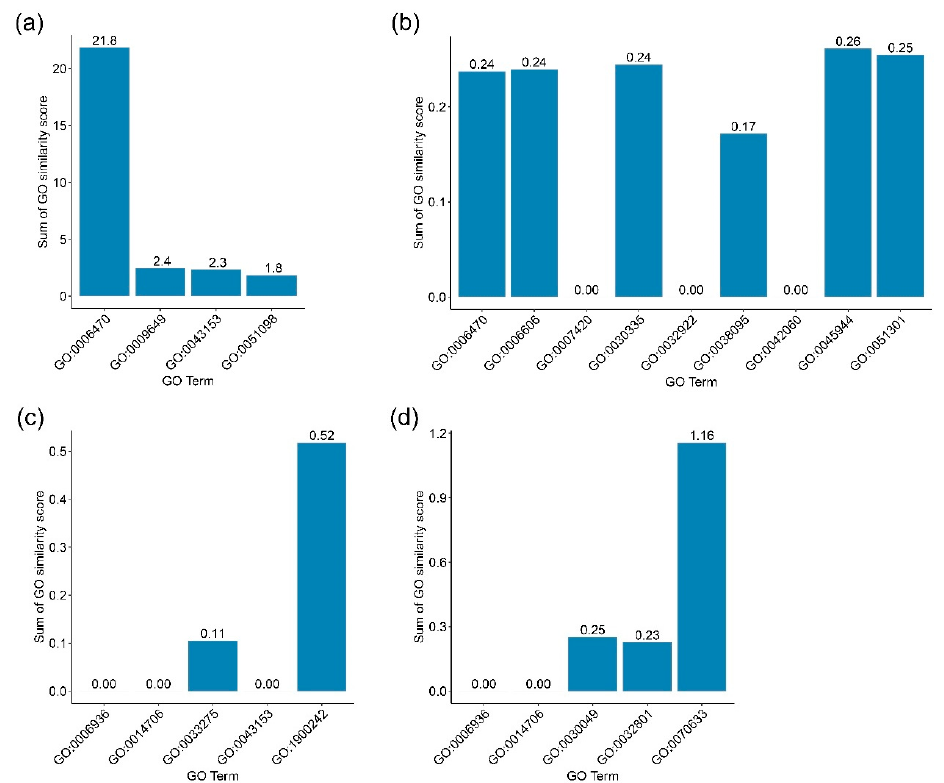
Figure 5. The sum of the GO similarity scores for the GO terms of the unknown function P. falciparum genes in relation to the GO terms of their neighboring genes. The bar plots ( a – d ) are the results for PF3D7_1303800 , PF3D7_1201000 , PF3D7_1248700 , and PF3D7_0401800 , respectively. For PF3D7_1303800 , GO:0006470 is found with the highest sum of the similarity scores. For PF3D7_1201000 , five GO terms with similarity scores around 0.25 are noticed. For PF3D7_1248700 , GO:1900242 shows the highest score. For PF3D7_0401800 , GO:0070633 shows the highest sum of similarity scores compared to the score of the other GO terms.